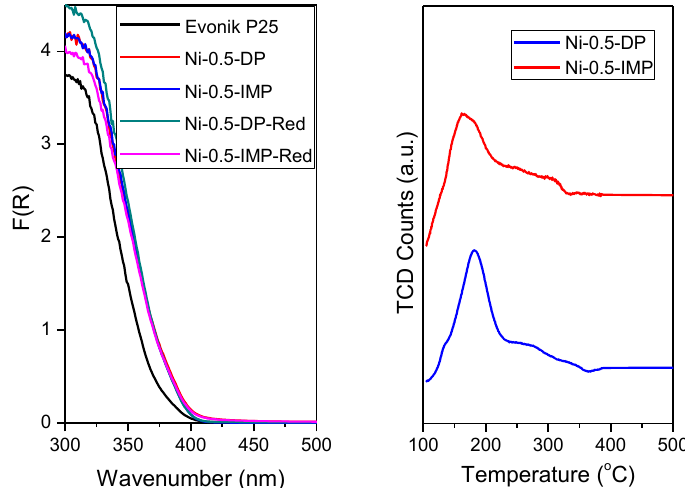
Figure 3. UV-vis spectra ( left ) and temperature-programmed reduction profiles ( right ) obtained for the catalysts prepared in this work. Table 2. Band-gap energy values of the solids as determined by UV-Vis spectroscopy.